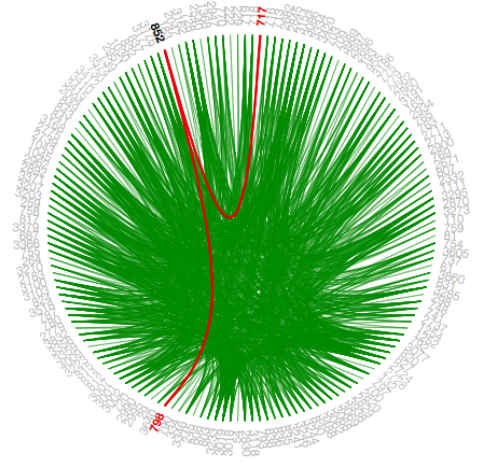
Figure A14. Demonstration of highlighting the path for the selected node.